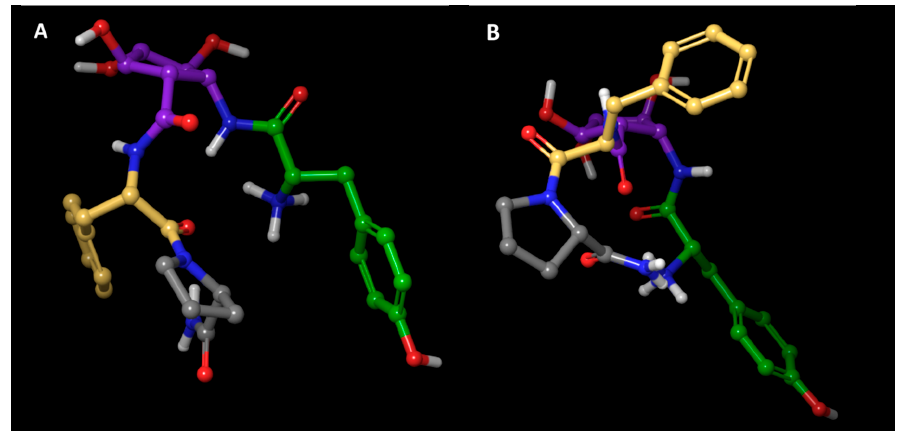
Figure 4. Comparison of the calculated conformations of 5a . ( A ) Free in solution. ( B ) Bound to the receptor. H white, O red, N blue, Tyr1 green, Pcp2 purple, Phe3 yellow, Pro4 grey.